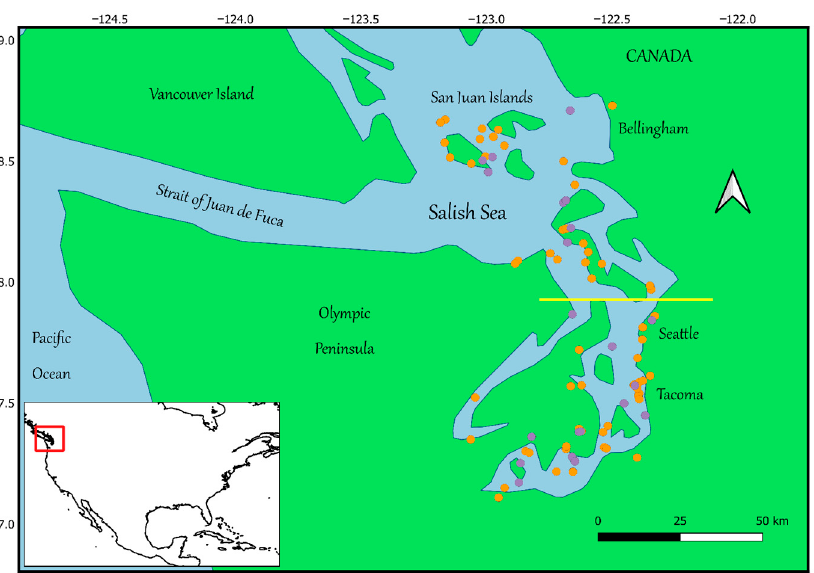
Figure 1. Distribution of stranded harbor seals (orange dots) and harbor porpoises (purple dots) sampled for antibiotic resistant organisms in the Salish Sea, Washington State, USA. Yellow hori- zontal line delineates northern and southern portions of the study area.